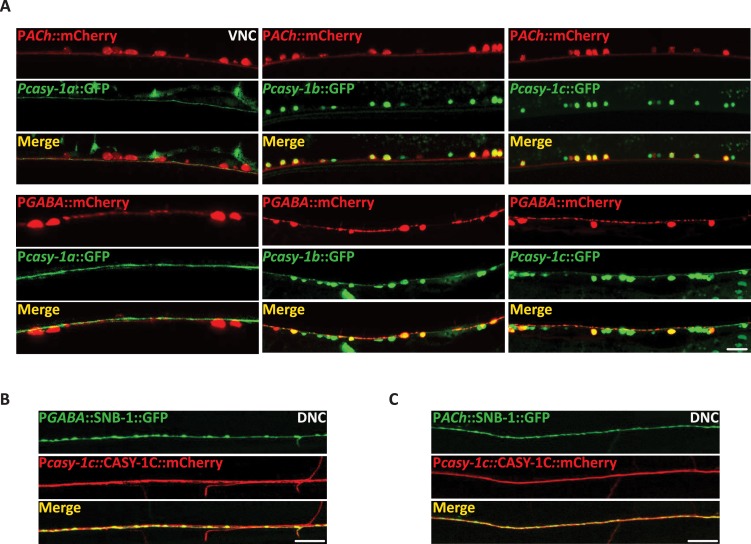
CASY-1 isoforms shows differential spatial localization.(A) Expression of GFP under isoform-specific casy-1 promoters. casy-1a transcriptional reporter does not co-localize with mCherry marked cholinergic or GABAergic motor neurons. casy-1b and casy-1c expression reporters show expression in both cholinergic and GABAergic motor neurons. Anterior is to the left in all panels. Scale bar, 8μm. (B) Representative fluorescent images of Pcasy-1c::CASY-1C::mCherry translational reporter showing co-localization with the GABAergic nuIs376 [Punc-25::SNB-1::GFP] pre-synaptic markers suggesting the presence of CASY-1C in the GABAergic NMJ pre-synaptic termini. Scale bar, 10μm. (C) Representative fluorescent images of Pcasy-1c::CASY-1C::mCherry translational reporter showing co-localization with the cholinergic nuIs152 [Punc-2129::SNB-1::GFP] pre-synaptic markers suggesting the presence of CASY-1C in the cholinergic synapses. Scale bar, 10μm.